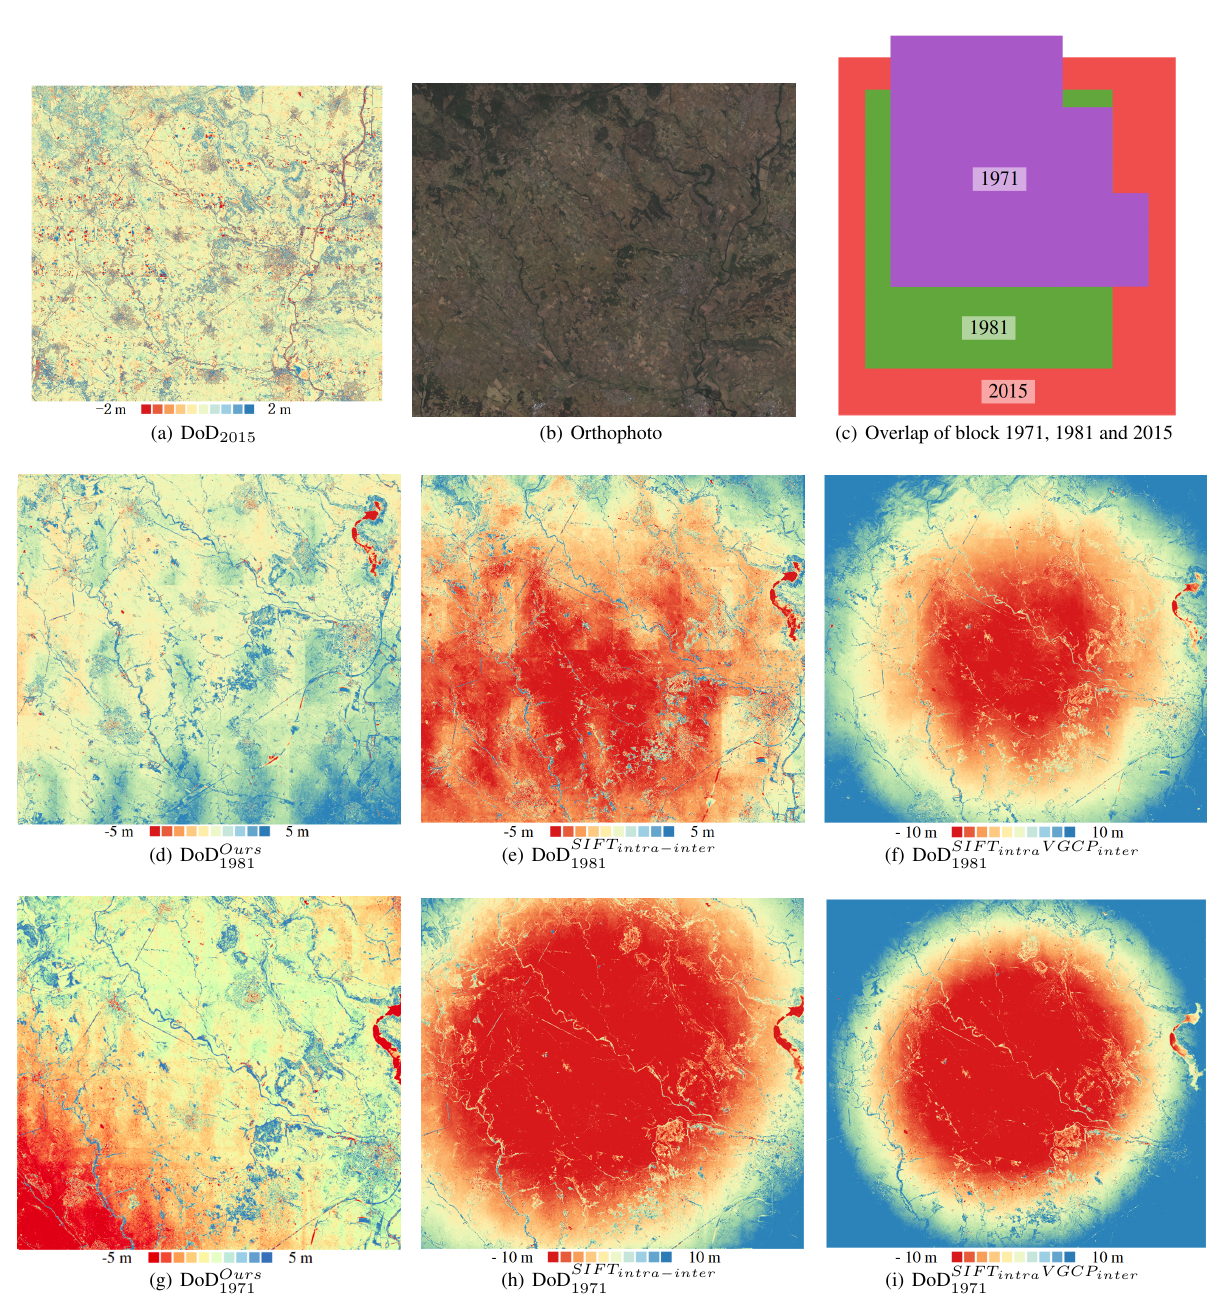
Figure 5. (a) DoD between GT DSM and 2015 DSM, (b) Orthophoto of the corresponding area, (c) Overlap of block 1971, 1981 and 2015, (d-f) DoD between GT DSM and 1981 DSM with Ours , SIFT intra − inter and SIFT intra V GCP inter , (g-i) DoD between GT DSM and 1971 DSM with Ours , SIFT intra − inter and SIFT intra V GCP